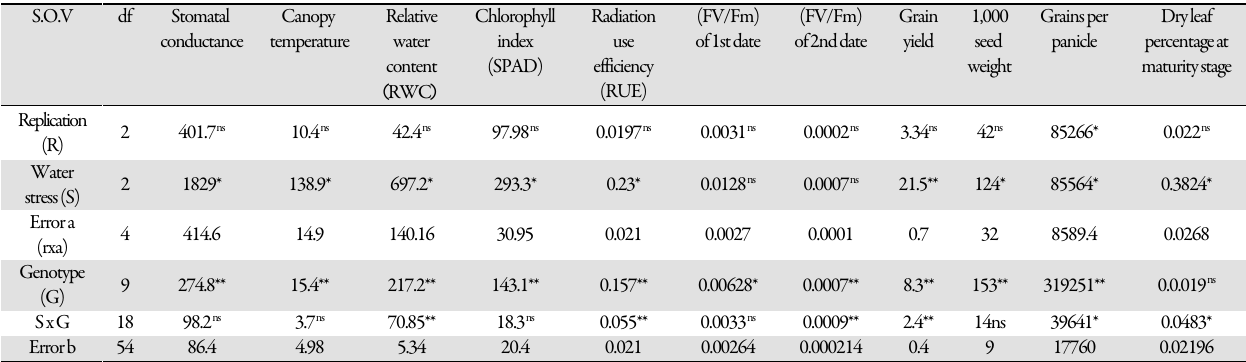
Table 1. Analysis of variance (mean square) of water stress on physiological traits in grain sorghum genotypes